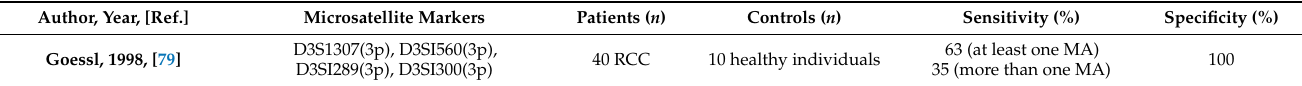
Table 1. Diagnostic data of microsatellite alterations (loss of heterozygosity [LOH] and/or